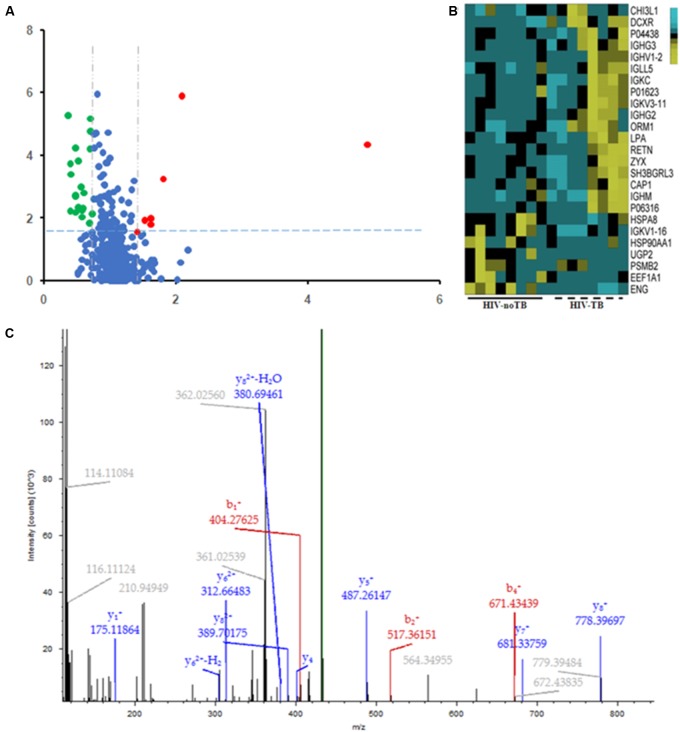
Differential expression patterns of proteins in the sera of HIV-TB co-infected patients and HIV-noTB controls. (A) Volcano plot of differentially expressed proteins in the two groups. 7 up-regulated proteins were colored in red, and 18 down-regulated proteins were colored in green. (B) Heat map illustrating the levels of 25 dysregulated serum proteins. All 25 proteins showed significant changes between the two groups (P < 0.05, fold change > 1.5 or < 0.37). Each group contained eight samples. (C) A typical MS/MS spectrum of one presentative peptide from endoglin protein.